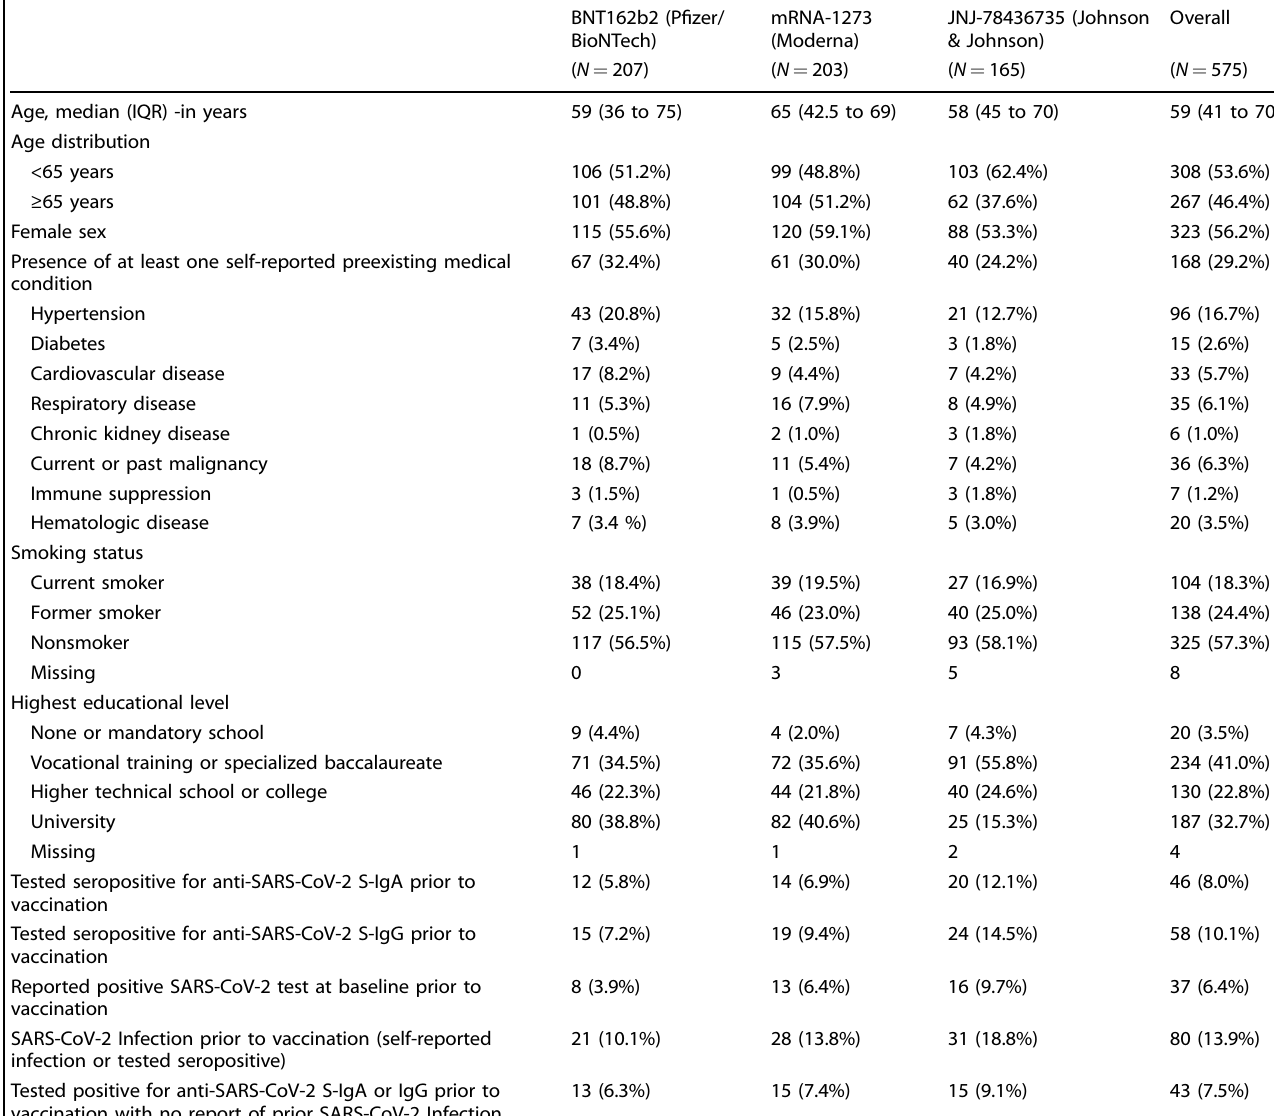
Table 1. Demographic and clinical characteristics of the study